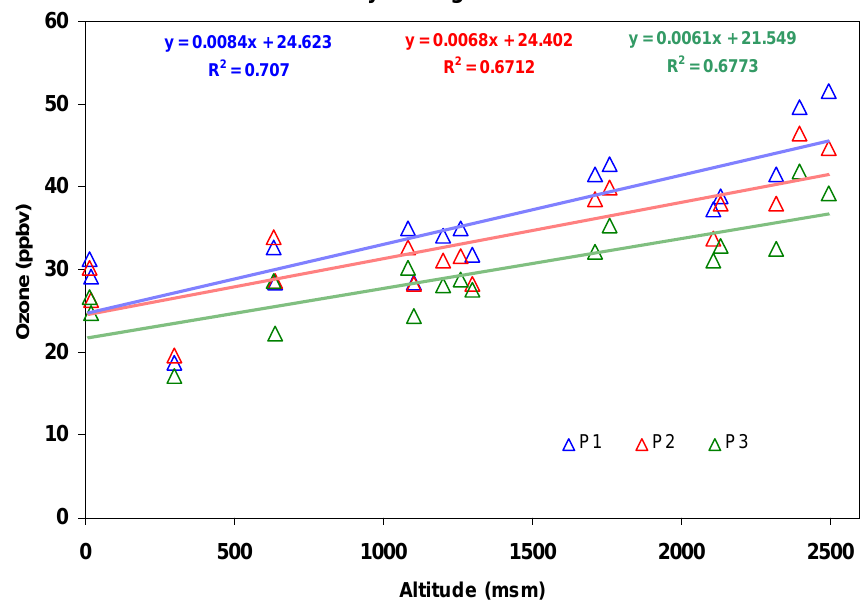
FIGURE 6 . Relationship between the ozone yearly average (ppbv) and the altitude (msm) of the sampling location for the three sampling periods (P1 = July 2001–June 2002; P2 = July 2002–June 2003; P3 = July 2003–June 2004).